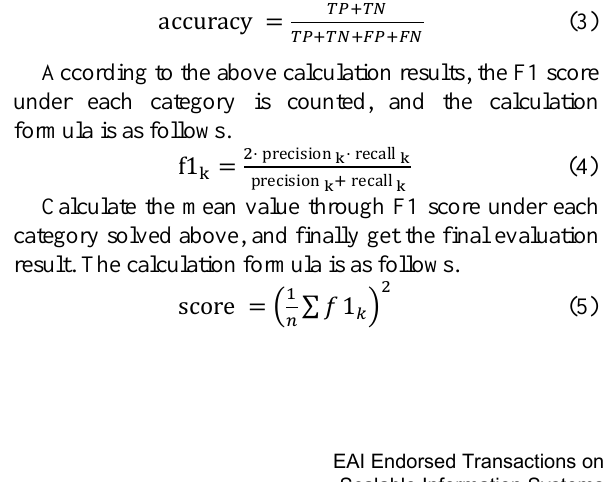
Table 2. Data feature